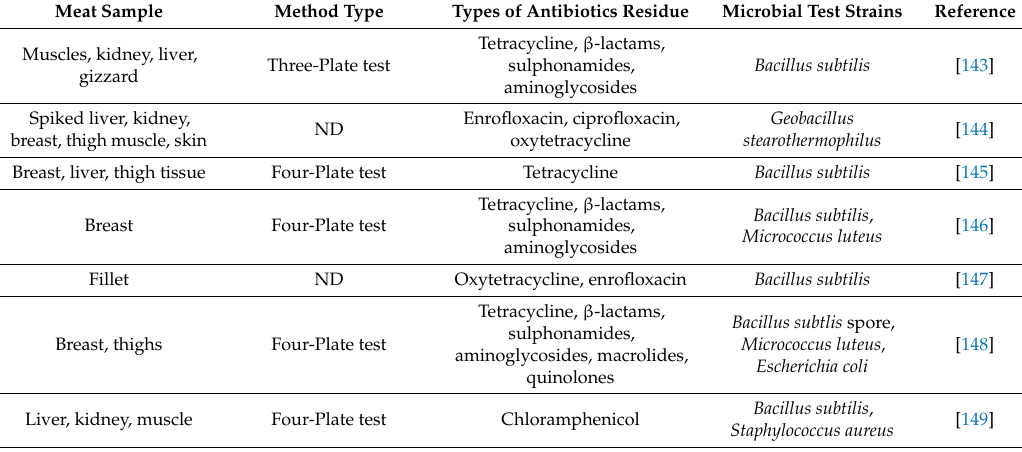
Table 9. Microbial inhibition-based approaches used for the detection of antibiotics residue in chicken meat.